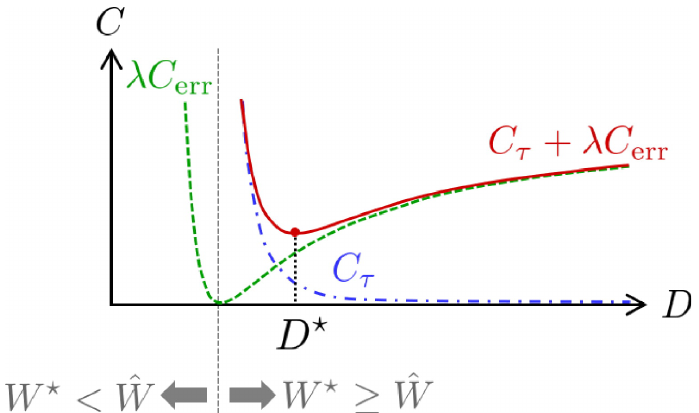
Figure 2. Illustration of the proposed cost function. The blue dash-dotted line is the trajectory cost, i.e., the cost of the minimum commanded torque change ( C τ ). The green dashed line is the cost of time (CoT), i.e., the squared error between tolerance and estimated hand endpoint variability ( C err ). The red solid line is the weighted sum of the trajectory cost and the CoT ( C τ + λ C err ). As mentioned in [18], infinitely slow movements are considered to be optimal for the trajectory costs without the